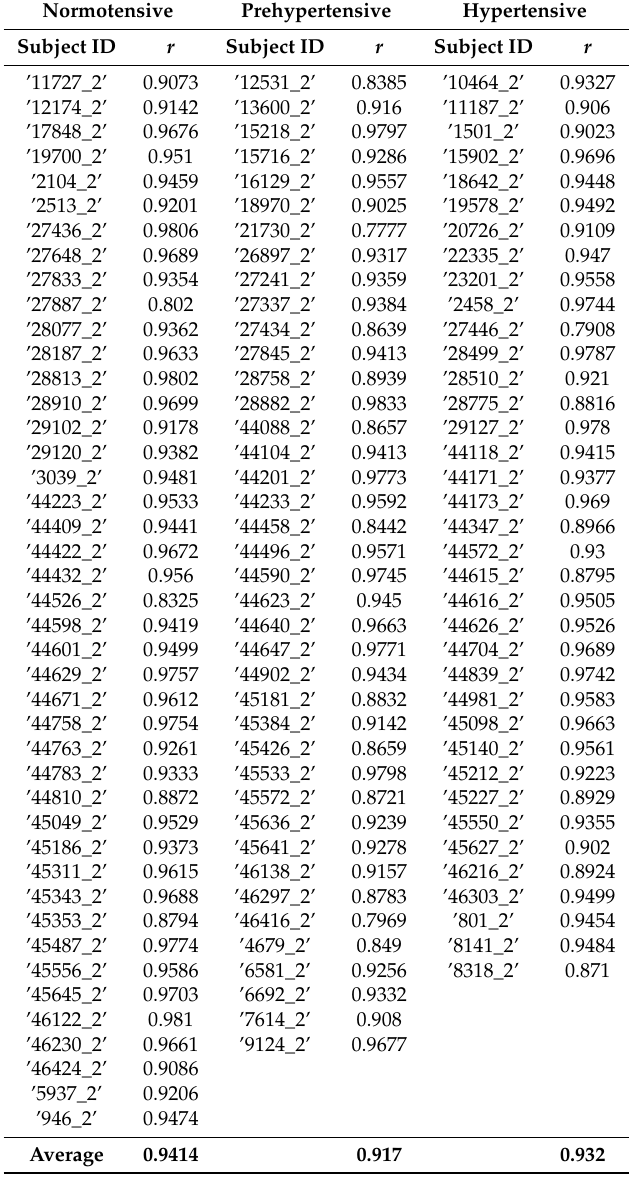
Table 1. In-phase correlation between photoplthysmogram (PPG) and arterial blood pressure (ABP)